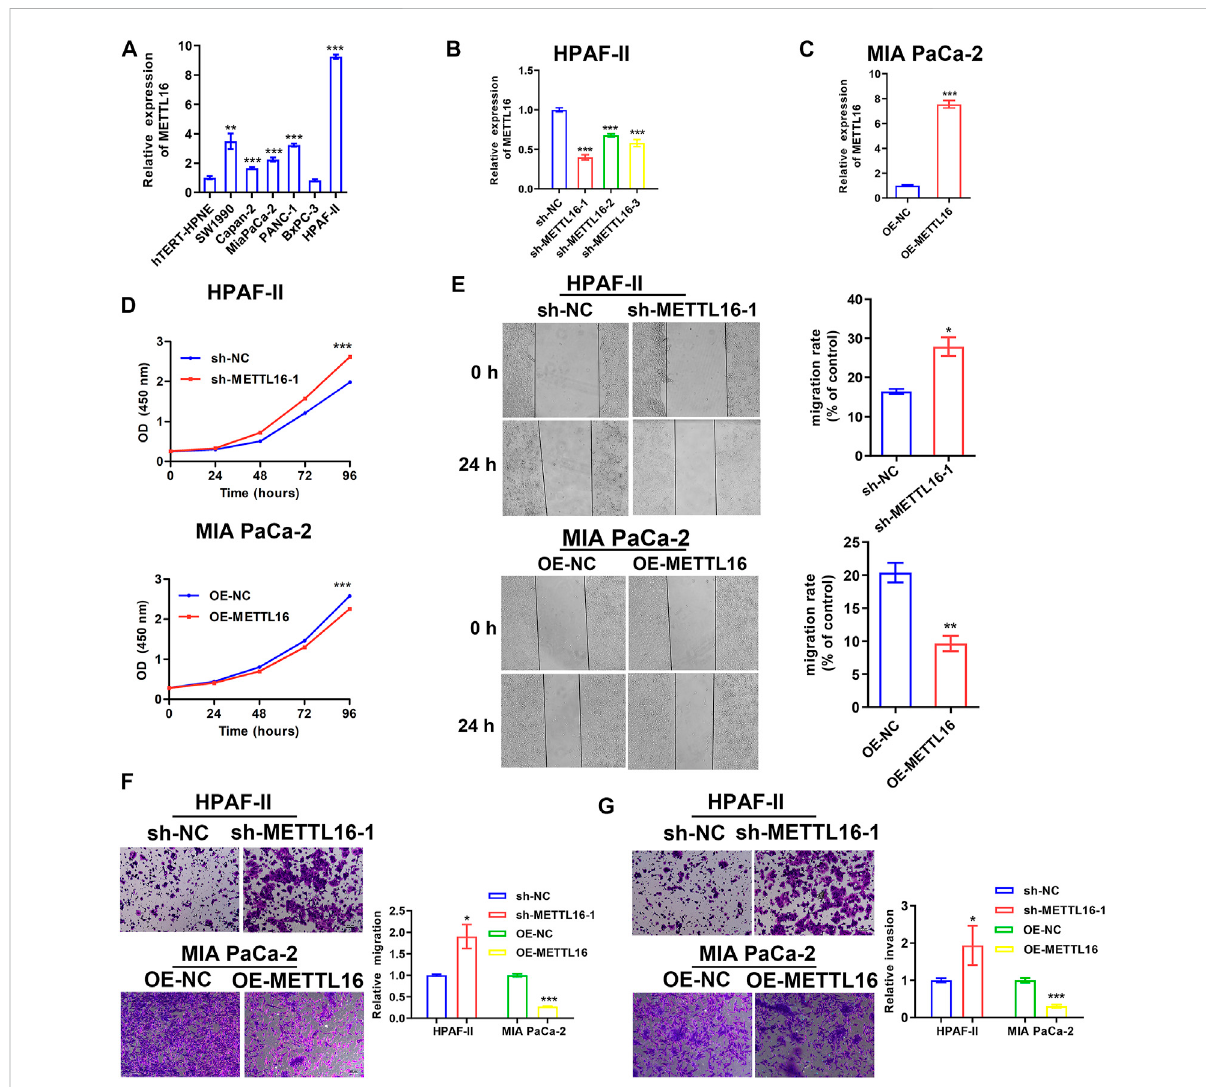
FIGURE 4 Tumor suppressor role of METTL16 in PDA in vitro . (A) Expression levels of METTL16 in PDA cell lines determined by qPCR. (B,C) Effective inhibition (B) and overexpression (C) systems for METTL16 were established. (D) Inhibition of METTL16 expression triggered cell growth (upper), whereas enhanced expression of METTL16 suppressed proliferation capacity (lower) in PDA cell lines. (E,F) Scratch healing assay (E) and transwell assay (F) indicated that suppression of METTL16 expression augmented migration potential, whereas upregulation of METTL16 expression attenuated migration capacity of PDA cells. (G) Reduction of METTL16 expression induced invasion, whereas over-expression of METTL16 inhibited invasive potential. Data are presented as mean ± SD. * p < 0.05, ** p < 0.01, *** p <